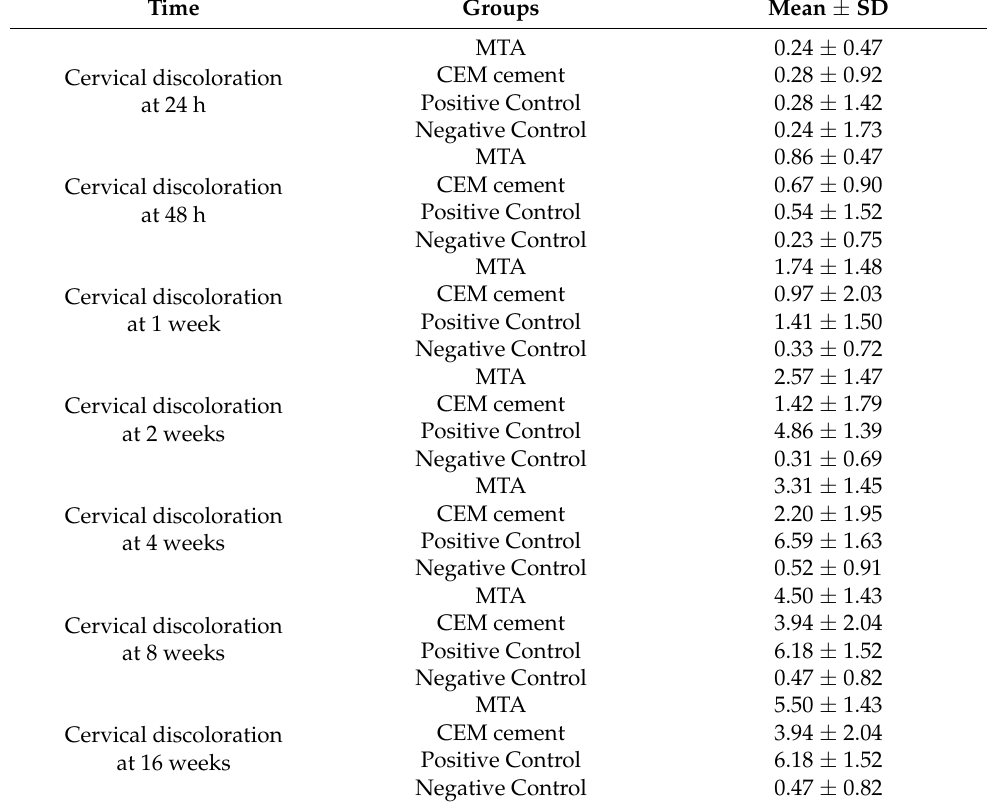
Figure 1. A sample of each experimental group at 16 weeks. ( A ) MTA; ( B ) CEM cement. Table 2. Discoloration values expressed as mean ± standard deviation for experimental and control groups over the time intervals.